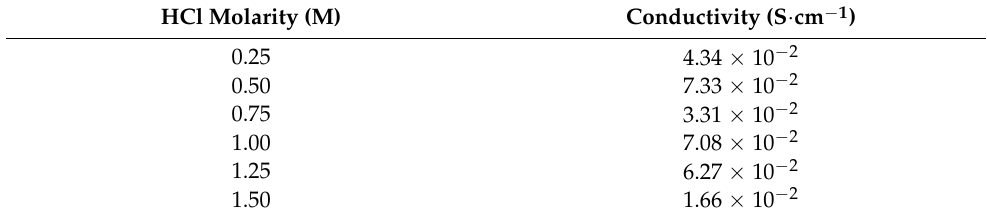
Table 8. Conductivity measurement of PANi synthesized with various HCl molarity